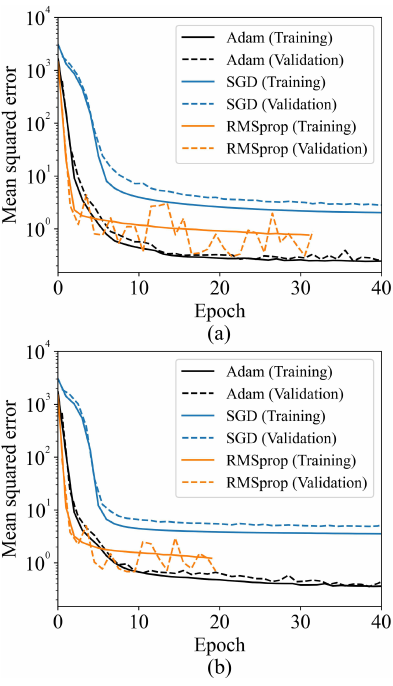
Figure 4. Training and validation losses for Defect 2 (a) with and (b) without the angle conditions as input parameters with different optimizers such as Adam (black), SGD with the gradient clipping value of 0.5 (blue) and RMSProp